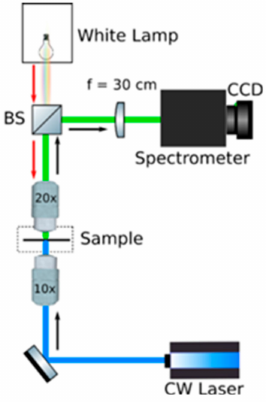
Figure 5. Sketch of the optical